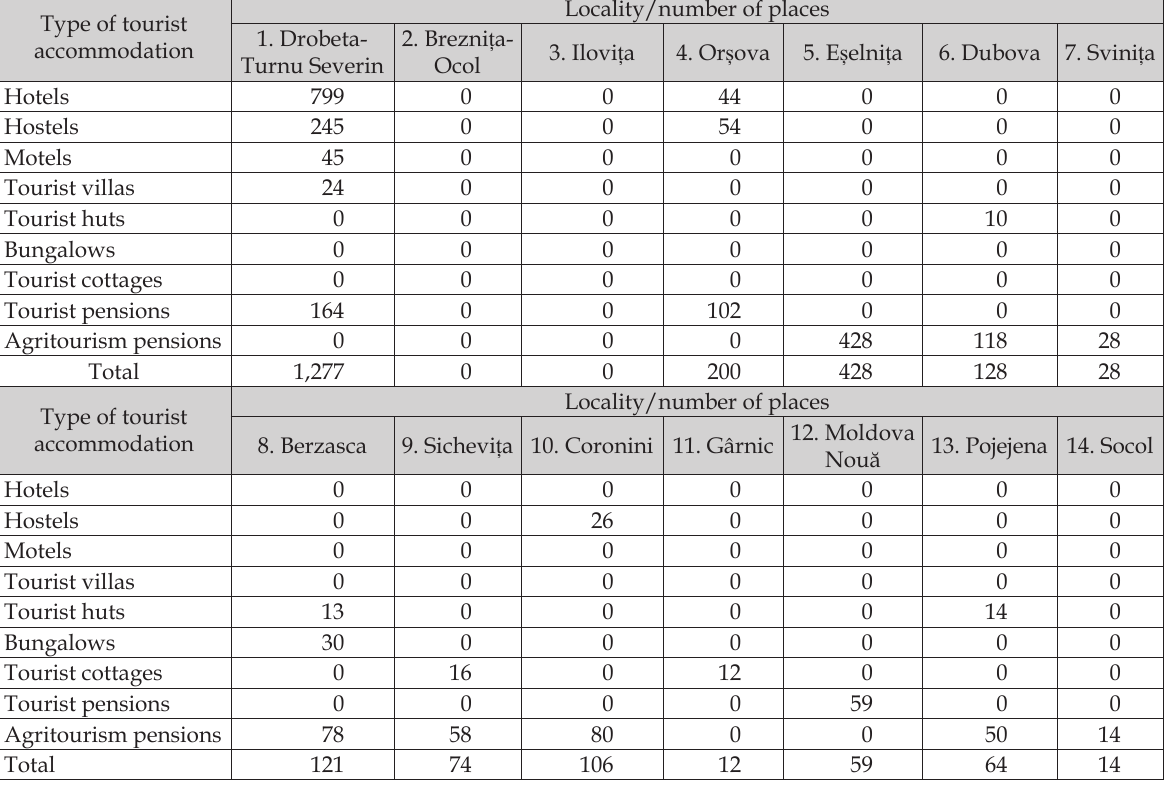
Table 2. Tourist accommodation capacity by type of tourist accommodation (2019). Type of tourist